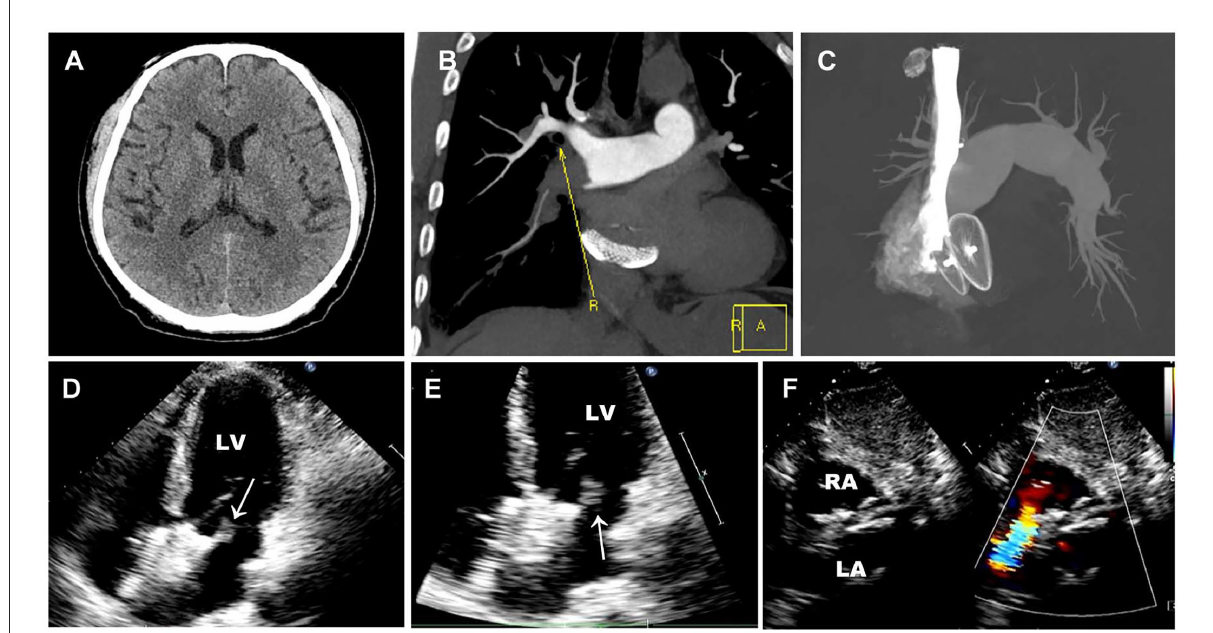
FIGURE1 Preoperative imaging examination. (A) Brain CT manifested as post-infraction of cerebral lacunar with no other significant abnormalities. (B,C) Pulmonary CT angiography presented embolism in the distal of the right pulmonary artery and its branches. (D–F) Preoperative TTE showed a 13 × 9mm thrombus floating in the left atrium without a shunt. White arrows represent